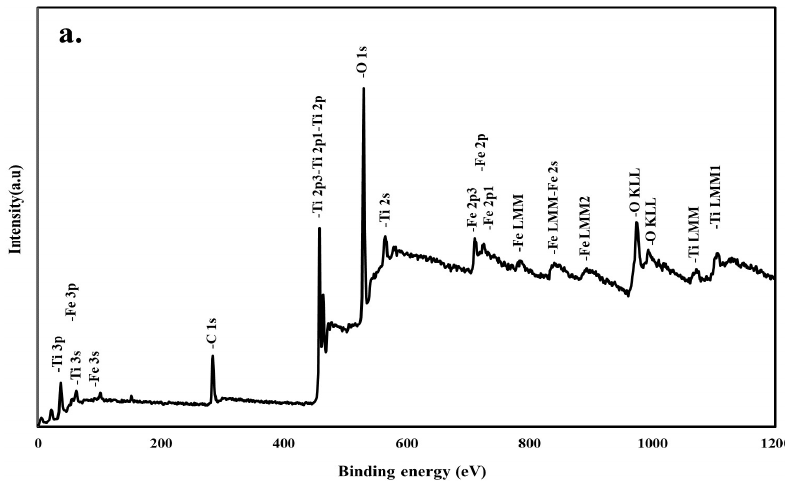
Figure 2. The XRD patterns for TNAs, Fe/TNAs-0.2, and